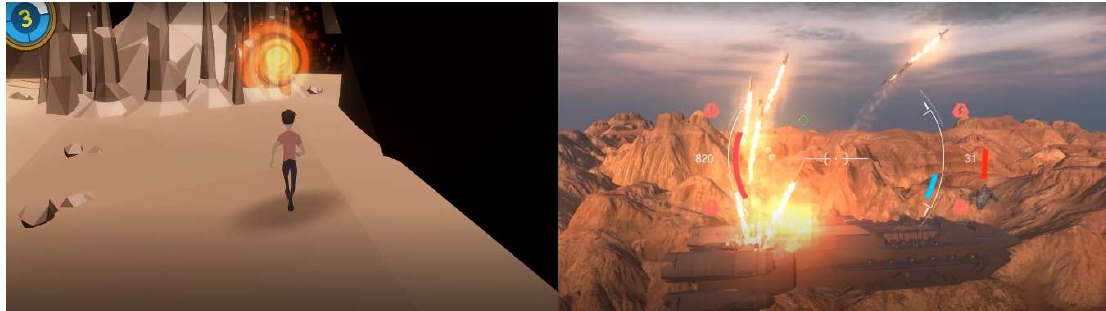
Figure 5. Development application step—Beta Project.